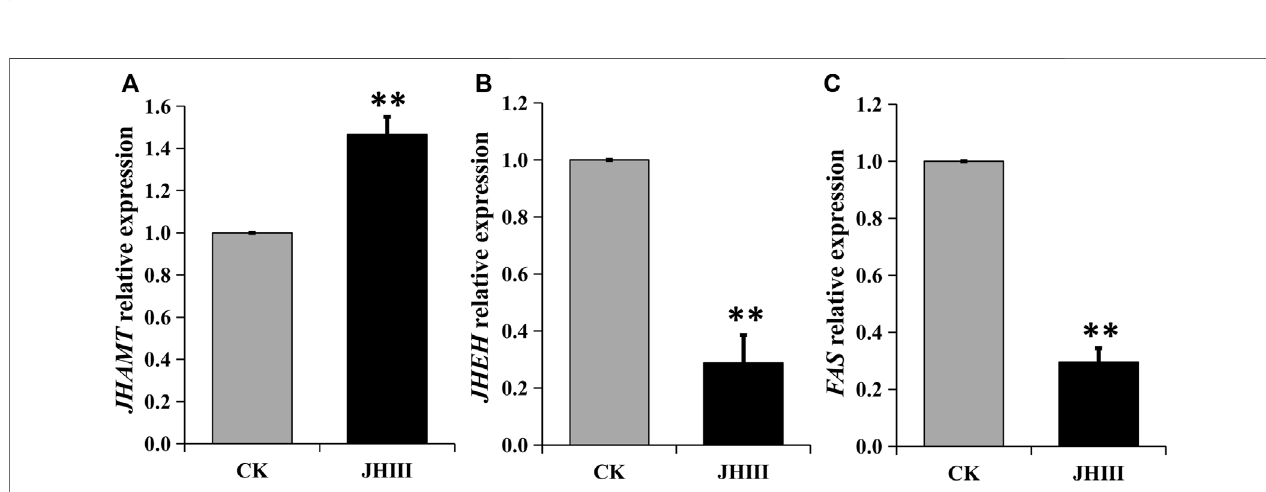
FIGURE 5 | Relative expression of JHAMT (A) , JHEH (B) , FAS (C) genes after JHIII injection. **, p < 0.01 (independent t -test).